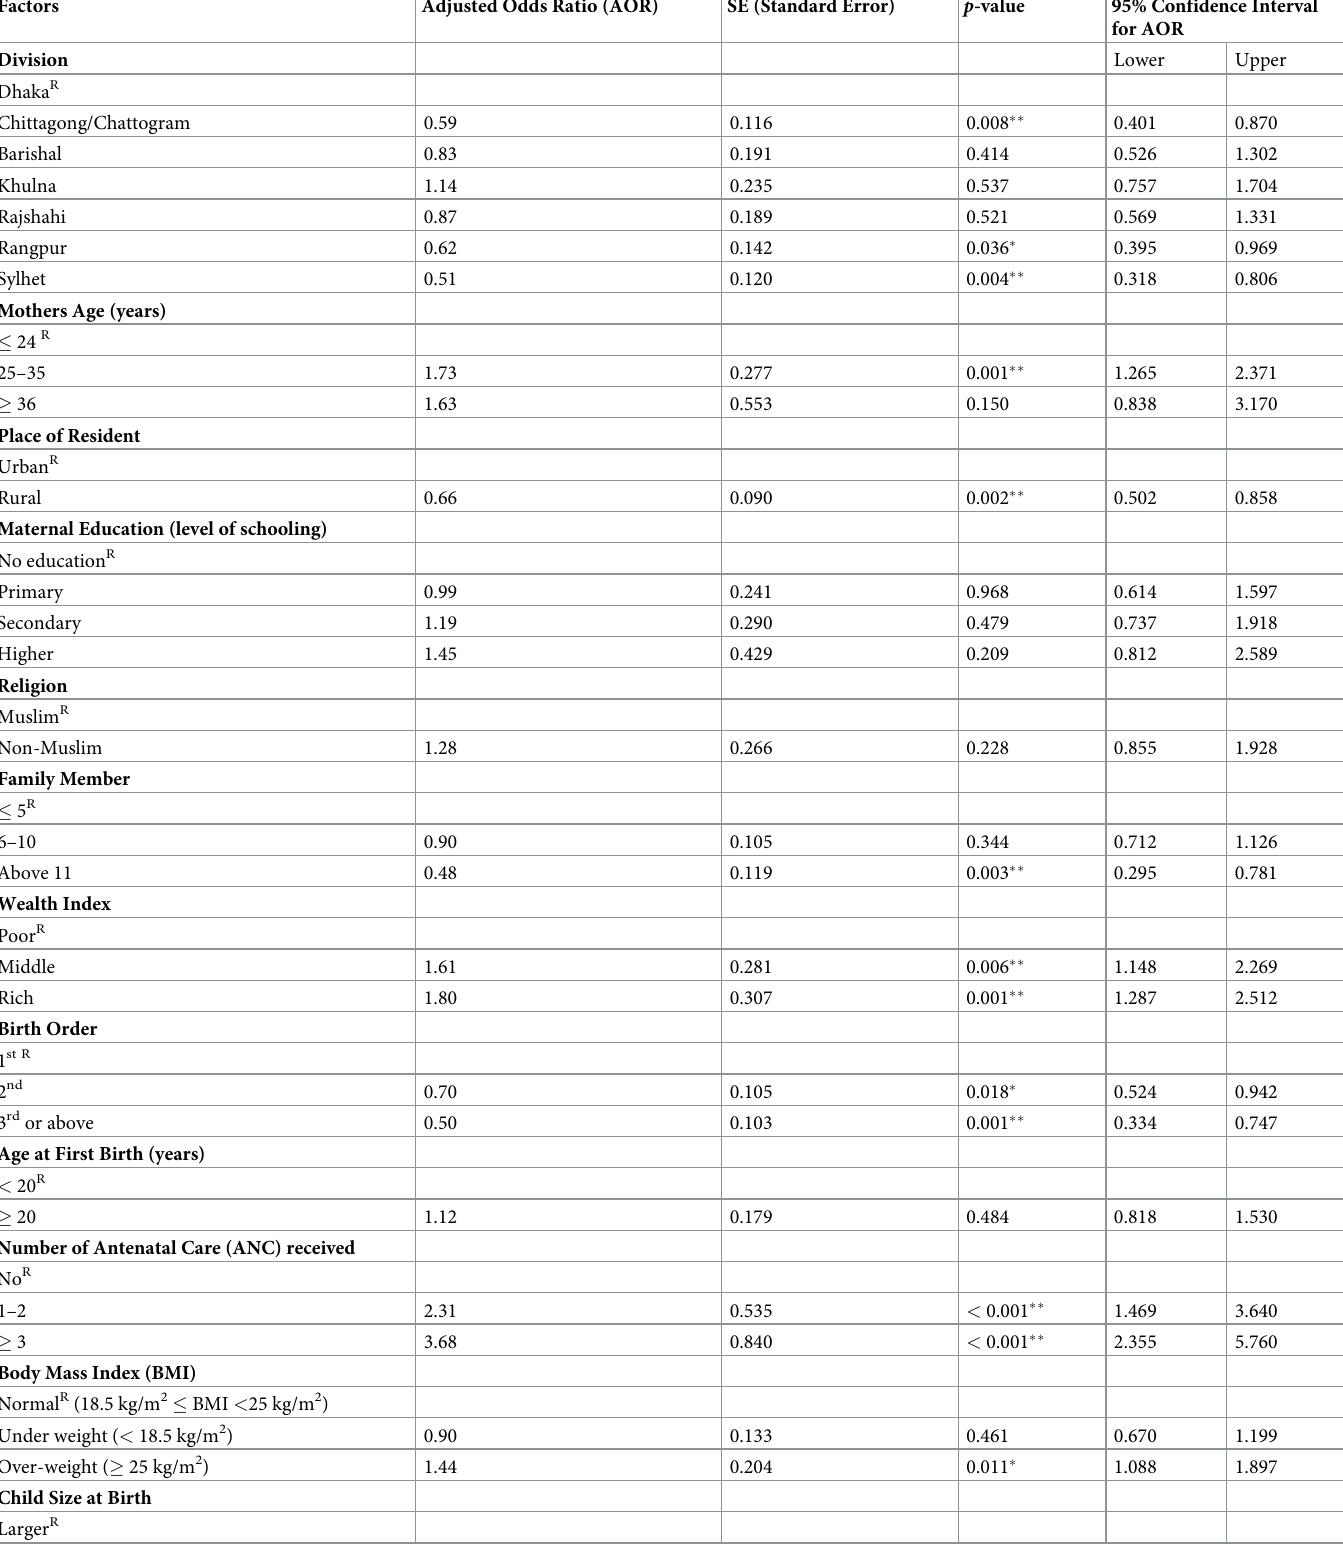
Table 4. Two-level logistic regression model to identify the factors associated with the CS delivery for the ever-married women of reproductive age in Bangladesh (N =